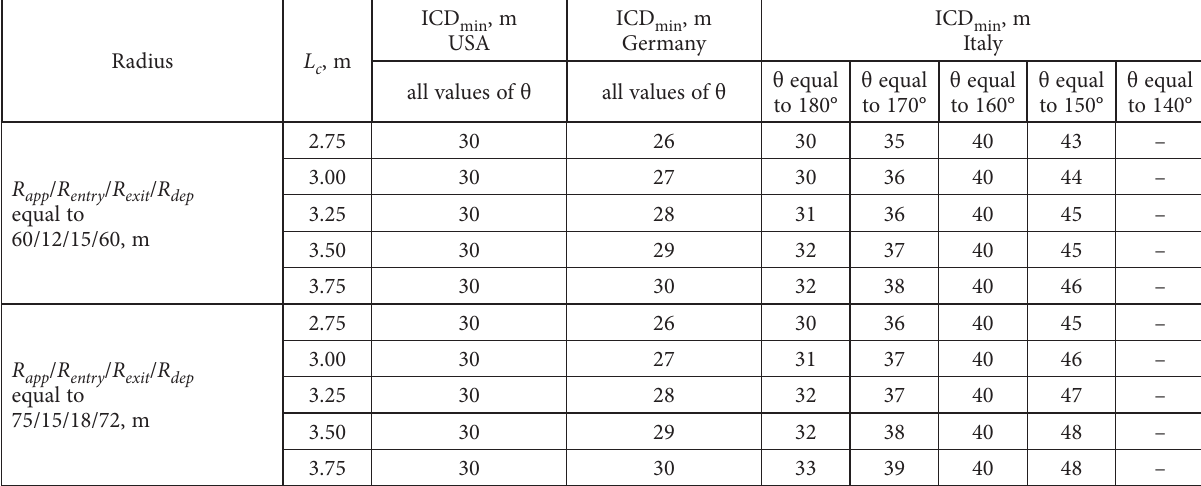
Table 5. Minimum value of ICD able to satisfy the entry path radius and deflection angle methods